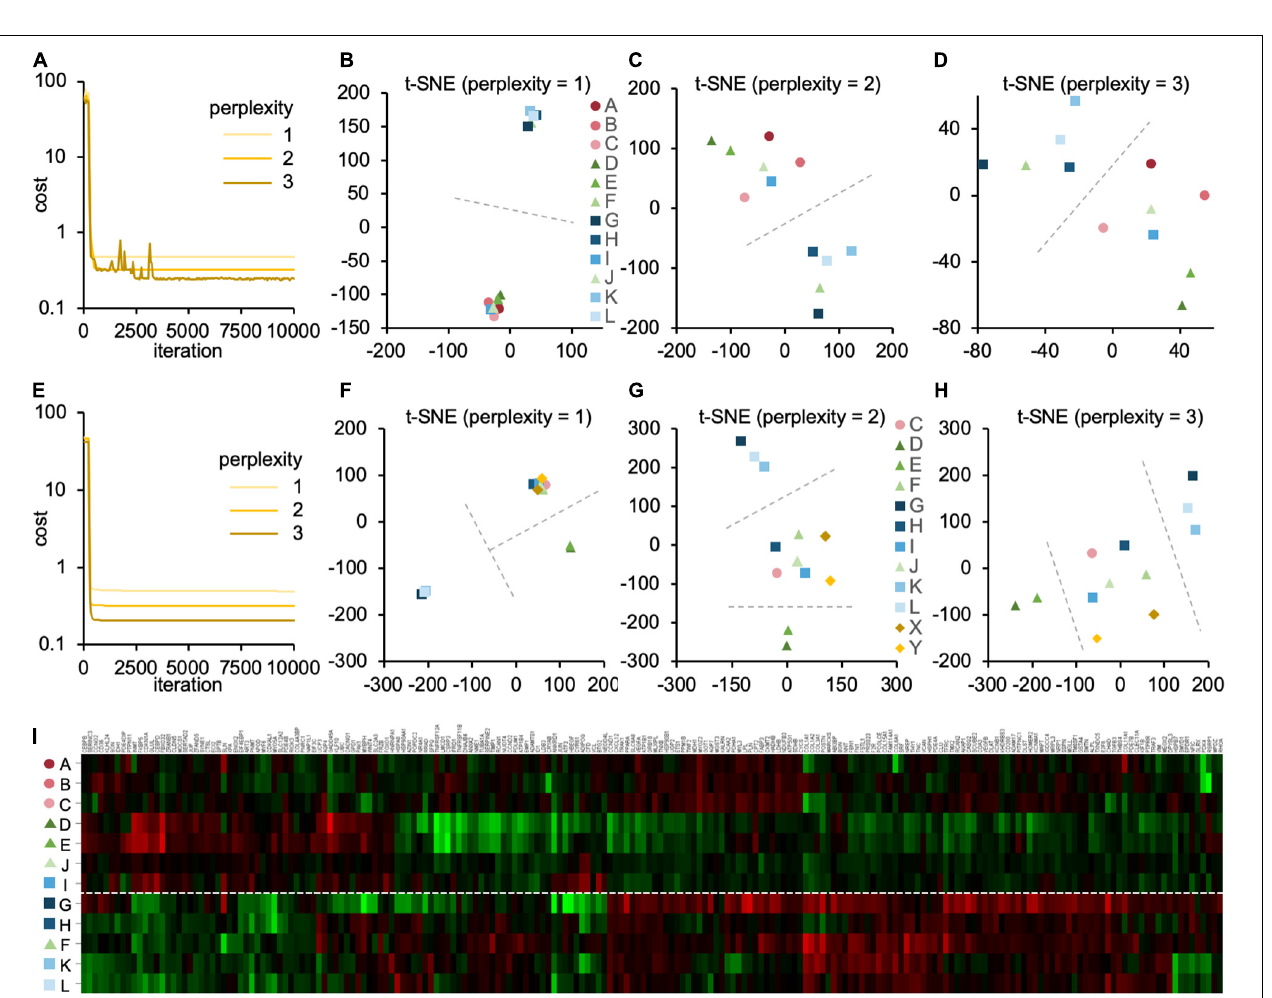
FIGURE 4 | The contribution of experimental conditions to the gene expression pattern. (A–D) The t-SNE analysis of the DNA array datasets obtained from skeletal muscle ( Table 2 ). (A) The convergence of cost values, reflecting the difference between the distance of each gene in multidimensions and that in 2D, over time at the perplexity of 1, 2, and 3. The t-SNE plots at perplexity = 1 (B) , 2 (C) , and 3 (D) are shown. (E–H) The t-SNE analysis of DNA array datasets obtained from endothelial cells ( Table 1 ) and skeletal muscle ( Table 2 ). (E) The convergence of cost values over time at the perplexity of 1, 2, and 3. The t-SNE plots at perplexity = 1 (F) , 2 (G) , and 3 (H) are shown. Dashed lines are drawn to guide the grouping of datasets. (I) The cluster analysis of DNA array datasets obtained from skeletal muscle ( Table 2 ).